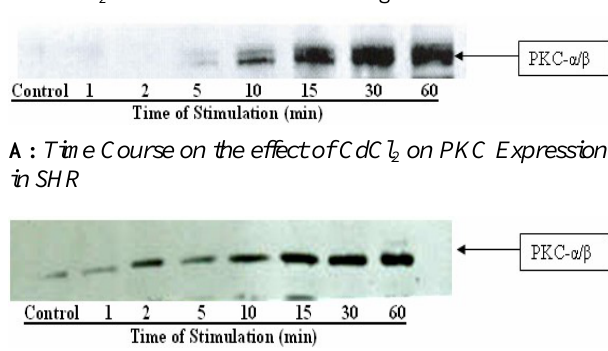
Figure 4: A time-dependent effect of CdCl on expression of 2 PKC in VSMCs of SHR (A) and WKY (B). Cells were stimulated with 4 µM of CdCl for 1-60 min. Cells were 2 harvested in lysis buffer as described in Material and Methods, and equal protein concentrations (20 µg) were analyzed on a 10% polyacrylamide gel and transferred to a nitrocellulose membrane. PKC-a/ß expression was determined by measuring specific phosphorylated PKC-a/ß by western blot.